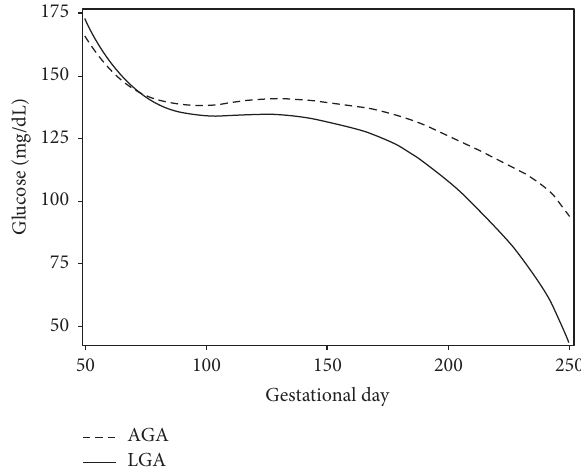
Figure 2: Fitted glucose curves of women with type 1 diabetes based on semiparametric regression modeling using penalized regression splines to estimate the rate of change in glucose ( 𝑦 -axis, mg/dL) against gestation time ( 𝑥 -axis, in days). The solid line represents fitted maternal glycemic profiles of mothers who gave birth to LGA infants; the dashed line represents fitted maternal glycemic profiles of mothers who gave birth to AGA infants.